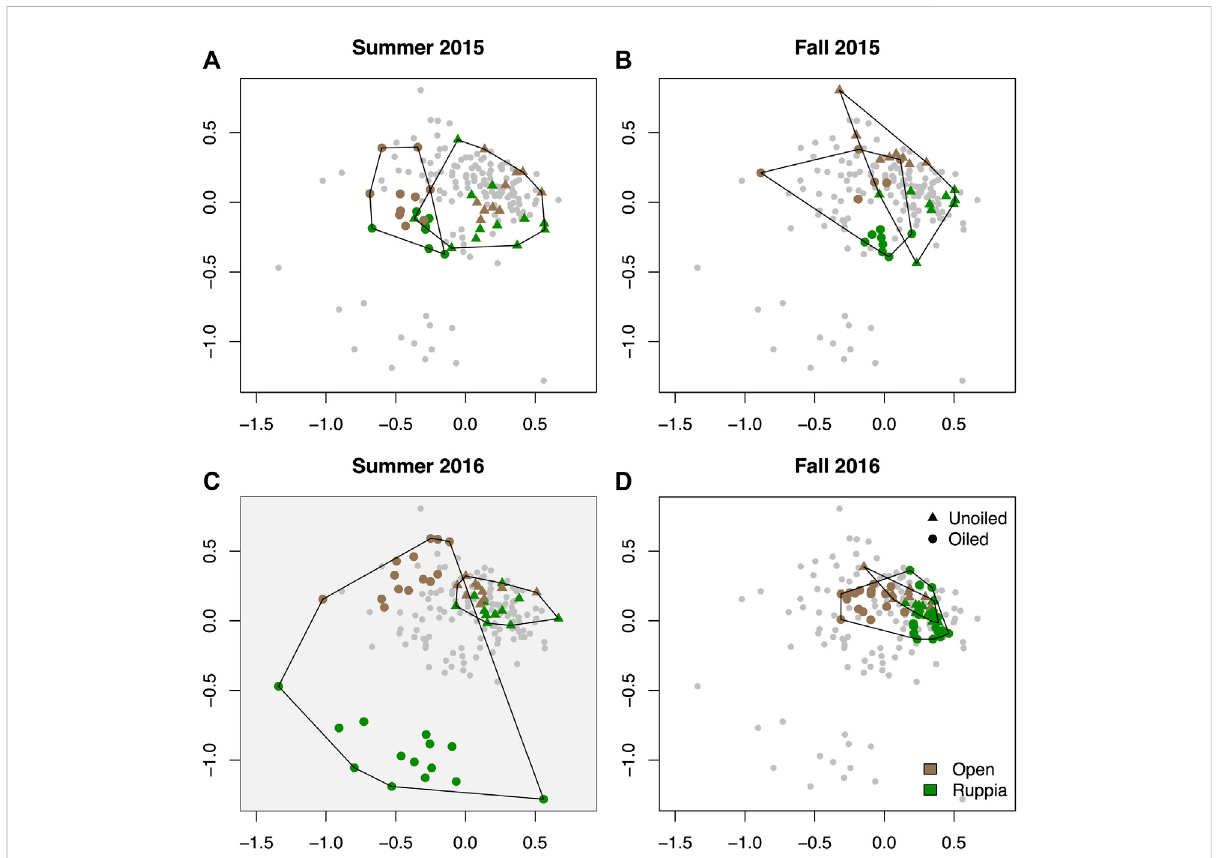
FIGURE 2 Nonmetric Multidimensional Scaling for infaunal communities in cores from unvegetated or Ruppia habitat at oiled vs. unoiled sites in each of the four sampling periods (A : Summer 2015; B : Fall 2015; C : Summer 2016; D : Fall 2016). A single ordination was performed using family-level abundance data from all four sampling periods (stress = 0.205). Each plot highlights samples from a single year/season. The convex hulls enclose all samplesfromagivensite,whilehabitatsaredifferentiatedusingcolor.Ineachsamplingperiod,bothSiteandHabitatweresigni fi